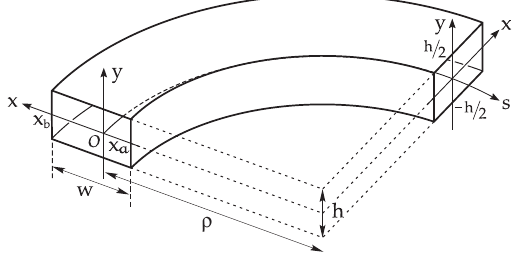
FIG. 1. Coordinate system and vacuum chamber. The refer- ence axis s lays on the median horizontal plane ( y ¼ 0 ) with a constant radius (cid:3) ; the horizontal axis x points outwardly. The pipe has a uniform cross section and infinite length along the reference orbit. The inner and outer wall positions are x respectively, the pipe width is given by w ¼ x < 0 < x x . The pipe height is h ; the upper and lower walls are a b located at y ¼ (cid:6) h= 2 ,